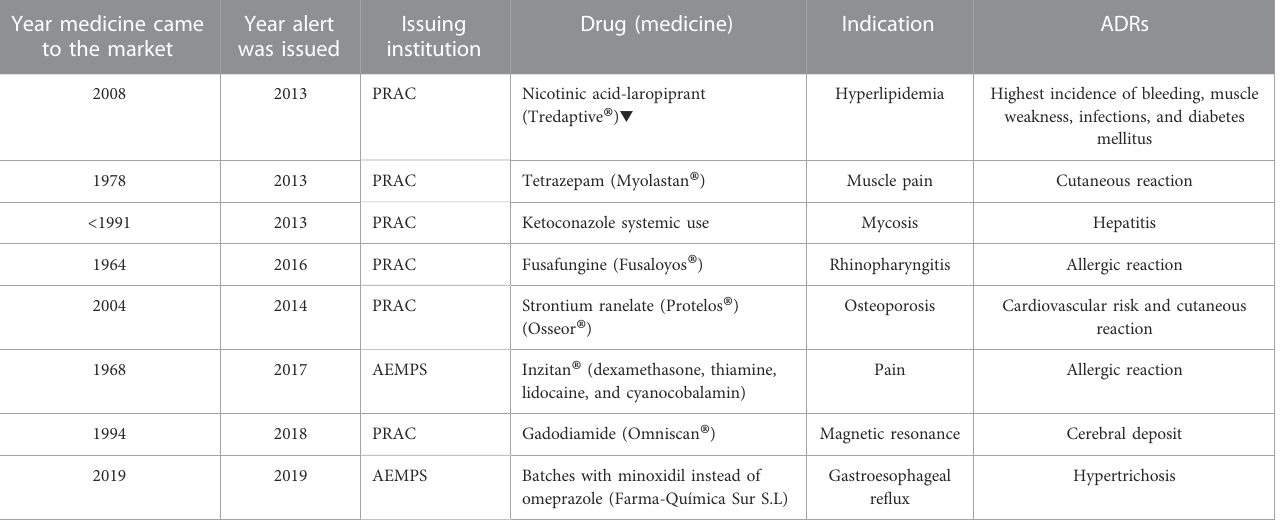
TABLE 9 Characteristics of medicines withdrawn from the market. Year medicine came to the